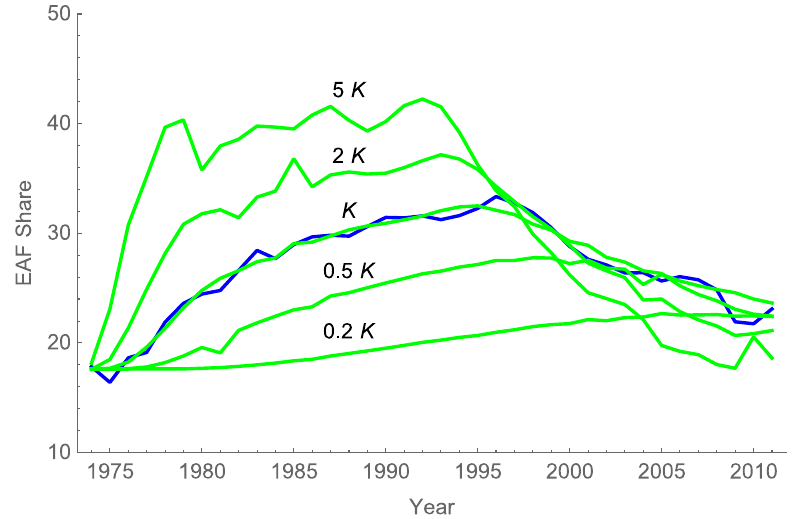
Figure 1. Influence of the parameter K (that summarises the combined effect of the barriers on the take-up of innovations) over the diffusion of EAF technology in Japan.